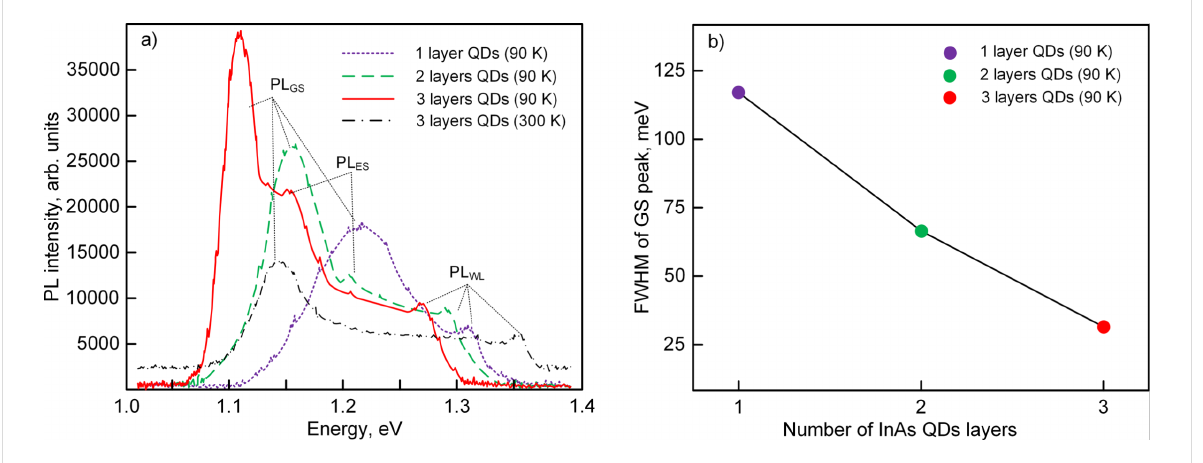
Figure 1: a) Photoluminescence spectra of samples with vertically stacked InAs QD arrays; b) full width at half maximum of ground state peaks as a function of the number of InAs QD